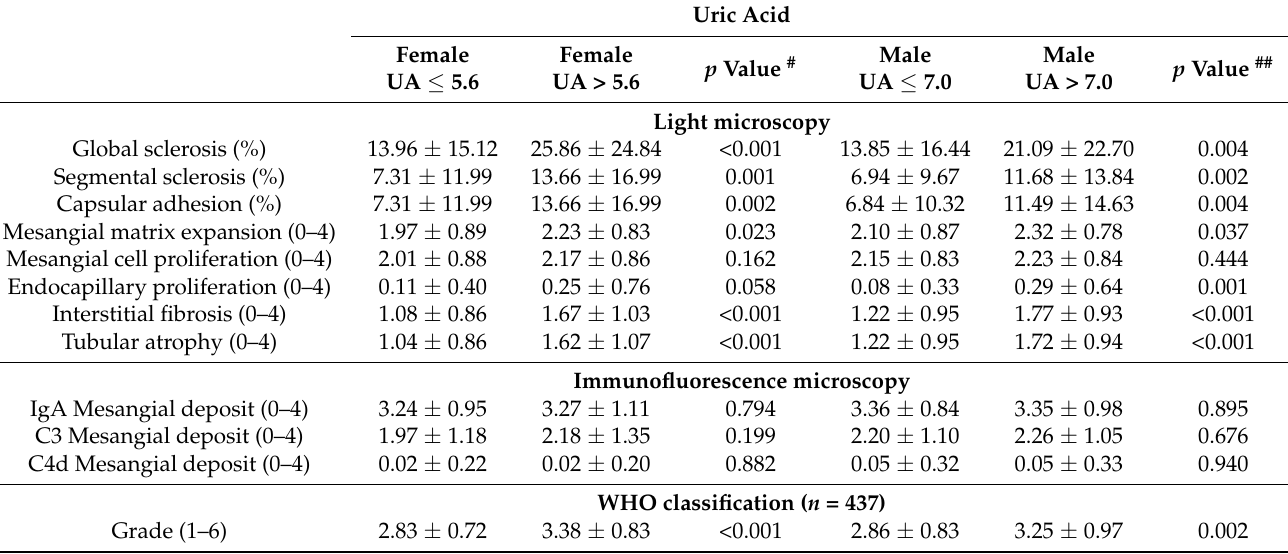
Table 3. Histopathological characteristics between the uric acid group.